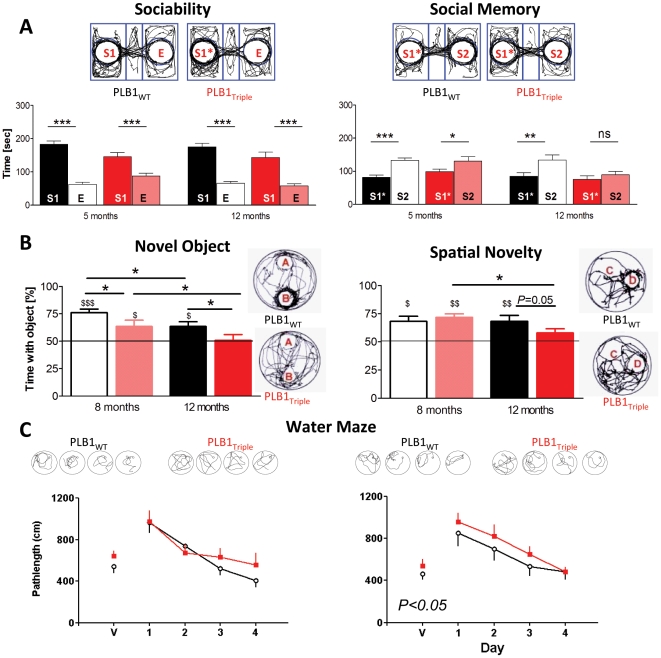
Recognition memory and learning in PLB1 mice.
A: Social recognition. Time (in seconds) spent with an unfamiliar stranger mouse (S1) and the corresponding empty compartment (E) at 5 and 12±1 months of age. During sociability (left), all groups spent significantly more time in the vicinity of the unfamiliar mouse compared to the empty holder. During the social memory phase (right), PLB1WT mice discriminated between the now more familiar first stranger (S1*) and a novel, unfamiliar stranger (S2) in both age groups. PLB1Triple only discriminated between the conspecifics at 5 months. Data are represented as means+SEM; n.s.: not significant; *: P<0.05; **:P<0.01; ***: P<0.001, arena and representative exploration patterns are also depicted. B: Object recognition and spatial novelty. Time (in %+SEM) spent with a novel object (left) or relocated object (right) in PLB1WT and PLB1Triple mice at 8 and 12±1 months. PLB1Triple performed worse than PLB1WT in both age groups during object recognition and did not discriminate between novel and familiar object at 12 months of age. At this age, recognition of spatial novelty was also affected. Significances are indicated between groups (*), a comparison with chance level is also given ($:P<0.05; $$: P<0.01; $$$: P<0.001). Examples path trajectories are illustrated on the right. C: Water maze learning. Mean daily path length (+ or − SEM) to reach a visible (V) platform, followed by spatial training to a submerged platform (days 1–4). At 5 and 12 months, PLB1Triple mice were able to locate the visible platform, but were significantly impaired at 12 (but not 5) months in the hidden platform task compared to PLB1WT (P<0.05). Arena set up with representative exploration patterns for day 1–4 (swim path) are depicted.